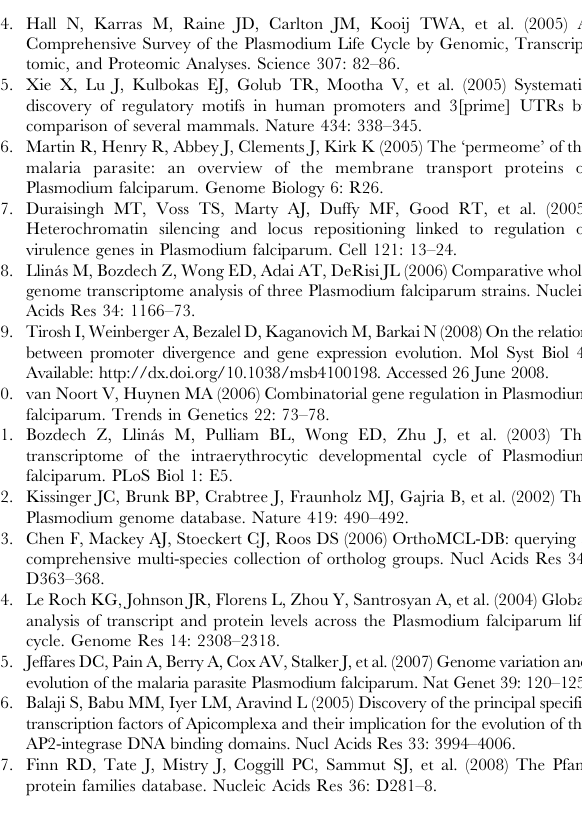
groups of proteins are shown in bold face. In all comparisons, transcription factors, zinc fingers, cell invasion and sexual develop- ment proteins are among the least constrained proteins. This table only includes data for all pairwise comparisons not involving P. falciparum . For analogous P. falciparum data see Table S1. Table S4 Statistics of 7-mers discovered in P. falciparum 2000 bp upstream regions. The table contains all 7-mers discovered in P. falciparum 2000 bp upstream regions, their number of occurrences, their number of conserved occurrences, their conservation rates and conservation scores (z-scores). Table S5 Assessment of the tendency of each gene group to rank among the genes with the most constrained upstream regions (high motif overlap) among all genes with orthologs in 2 particular species. The alternative hypothesis that genes in a group rank among the most constrained was tested with the Wilcoxon rank- sum test. The p-values of the 5 most constrained groups of proteins are shown in bold face. Ion transport, sexual development, cell invasion, chromatin assembly, transcription factor and CCCH zinc finger genes have more constrained upstream regions than the other groups of proteins considered. This table includes data used to construct Figure 3. Table S6 Group rankings based on level of constraint on upstream regions as determined by the Wilcoxon rank-sum test for each of the 5 cross-species comparisons presented in Table S5. The smaller the rank, the greater the observed constraint. Gene groups are sorted by sum of ranks.